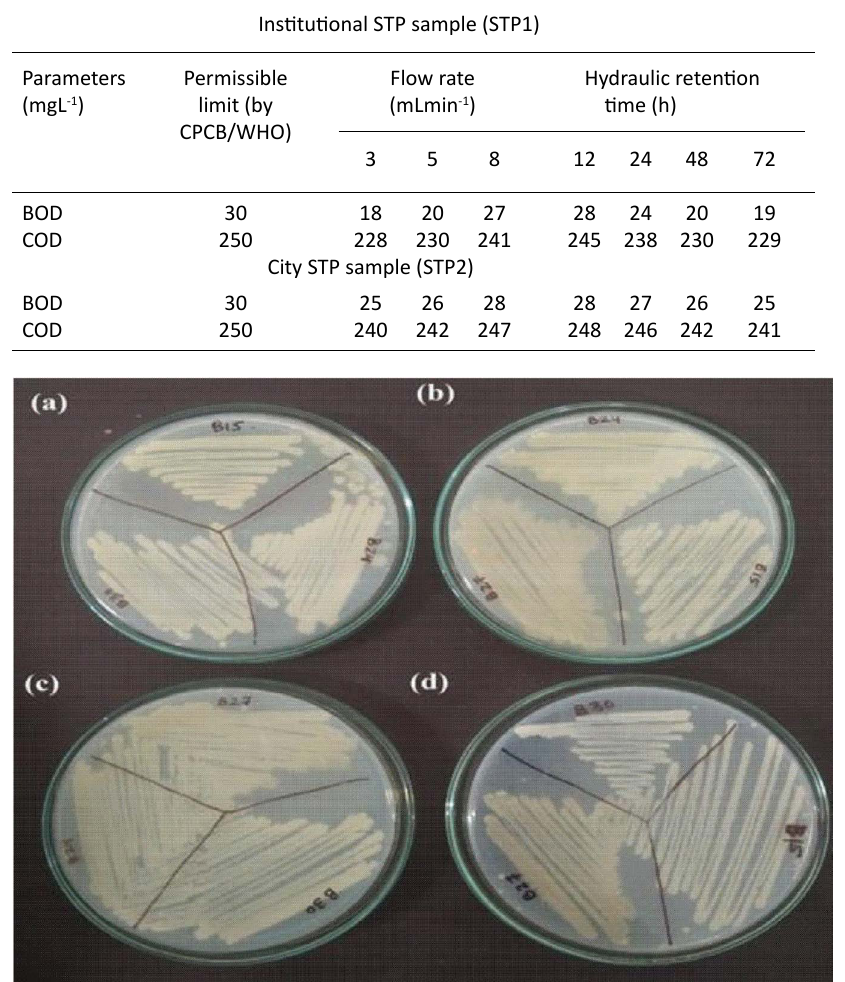
Fig. 2. Representation of prepared consortia on nutrient agar plates; (a) Consortium 1, (b) Consortium 2, (c)